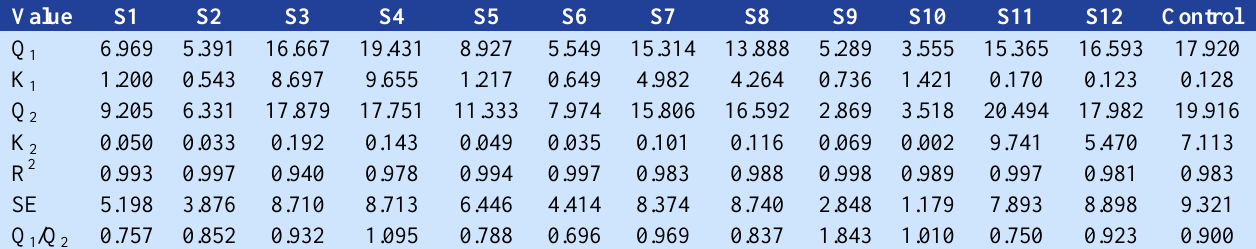
Table 6. Estimated parameters of the two first-order reaction model used to describe release kinetics of Cr with 0.01 m NaNO3 Value